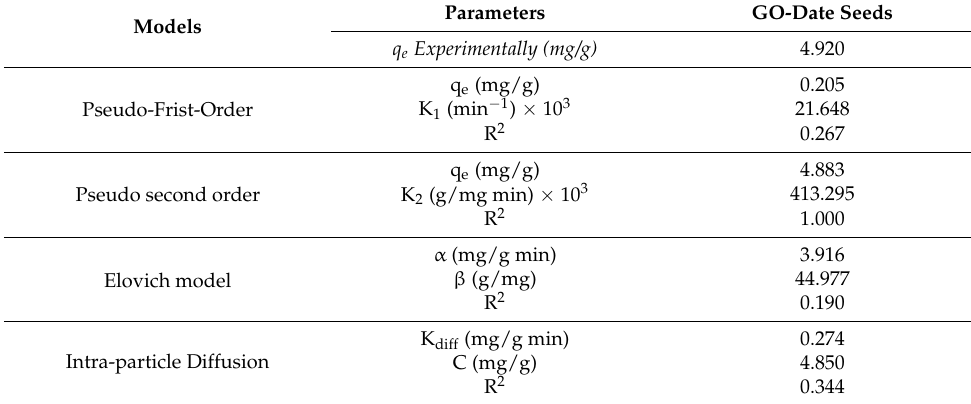
Figure 10. Kinetic models of PTZS dye adsorption GO-date Seeds ( A ) Pseudo − First − Order; ( B ) Pseudo − Second − Order; ( C ) Elovich; ( D ) Weber − Moris Intra − Particle Diffusion Model. Table 1. Coefficients of Pseudo-First-Order, Pseudo-Second-Order, Elovich kinetic, and Weber-Moris Intra-particle Diffusion models for the adsorption of GO-date Seeds onto PTZS.